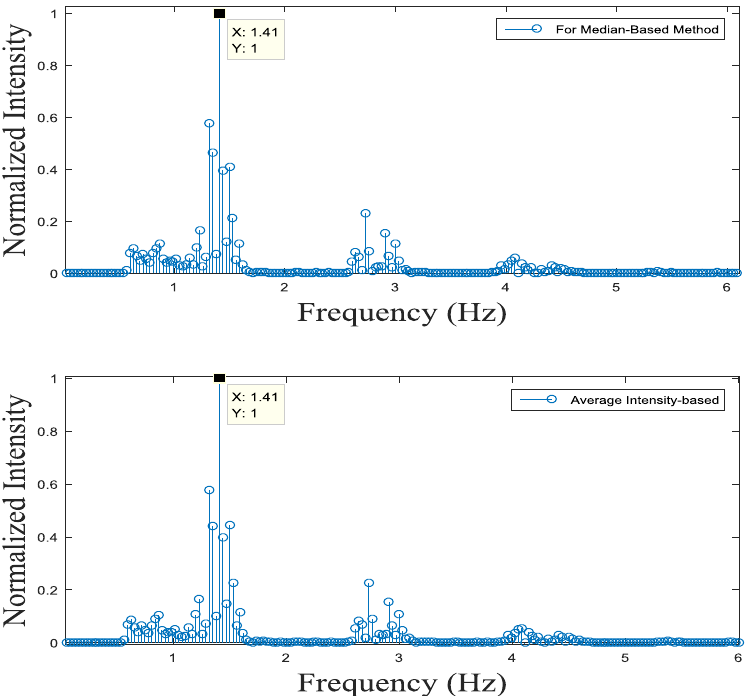
Figure 13. Frequency-domain analysis of heart rhythms obtained by the proposed (median-based) and conventional methods.